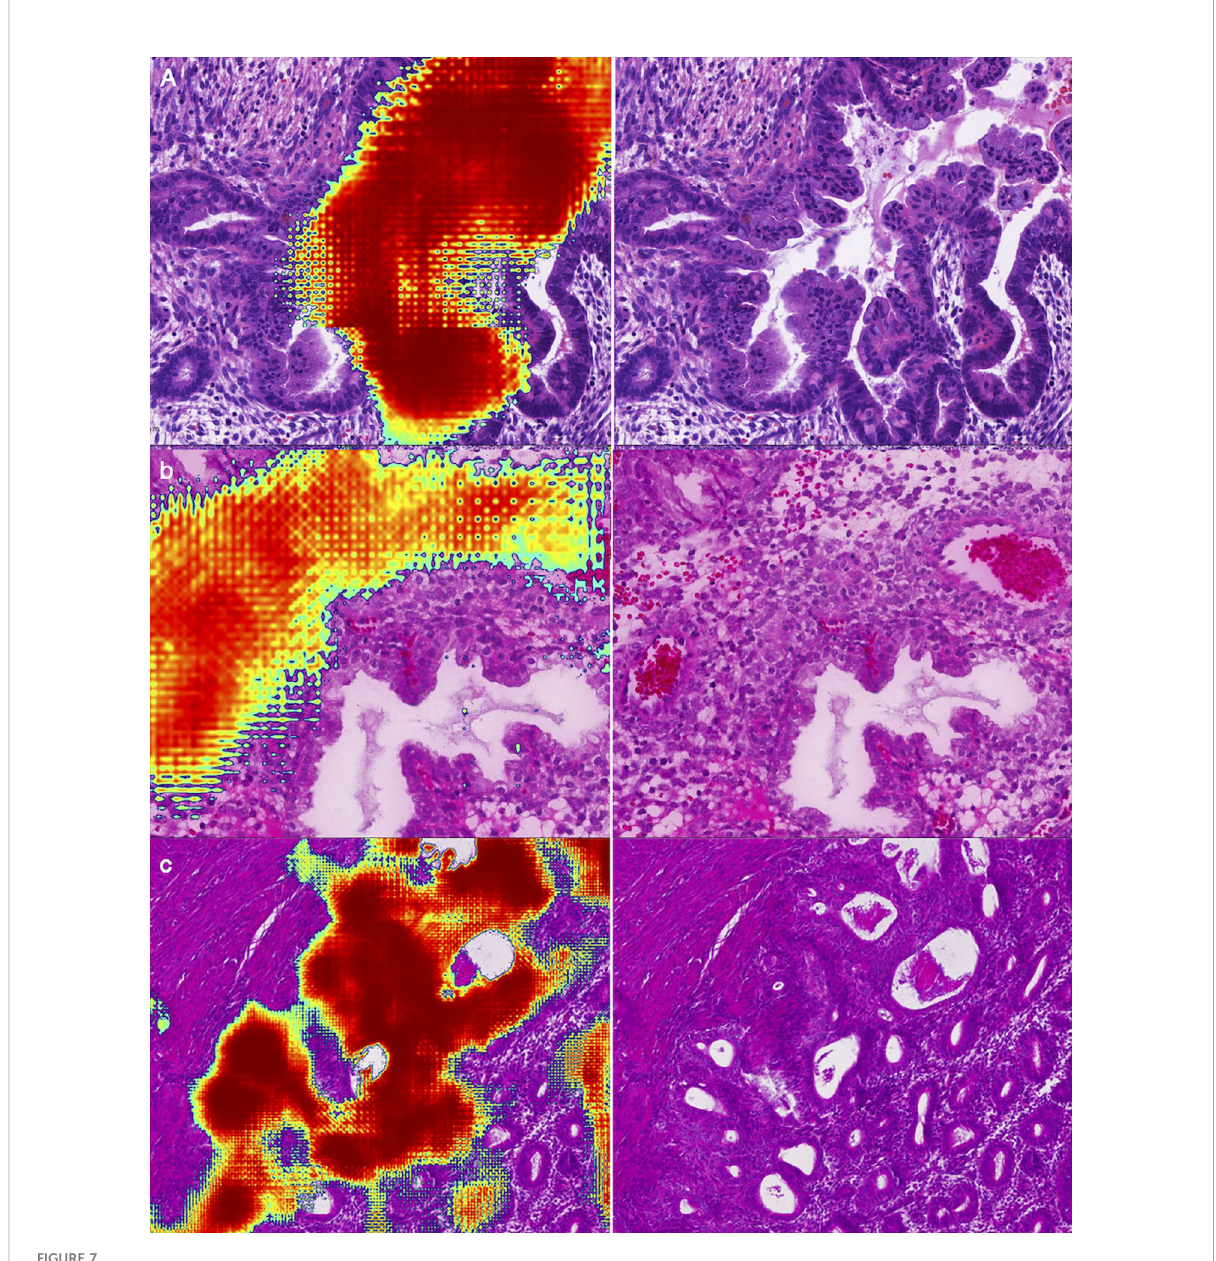
FIGURE 7 Representative examples of false positives: (A) Mucous metaplasia of endometrial glands with papillary hyperplasia. (B) Decidualization of stromal cells with epithelioid morphology. (C) Endometrium in the proliferative